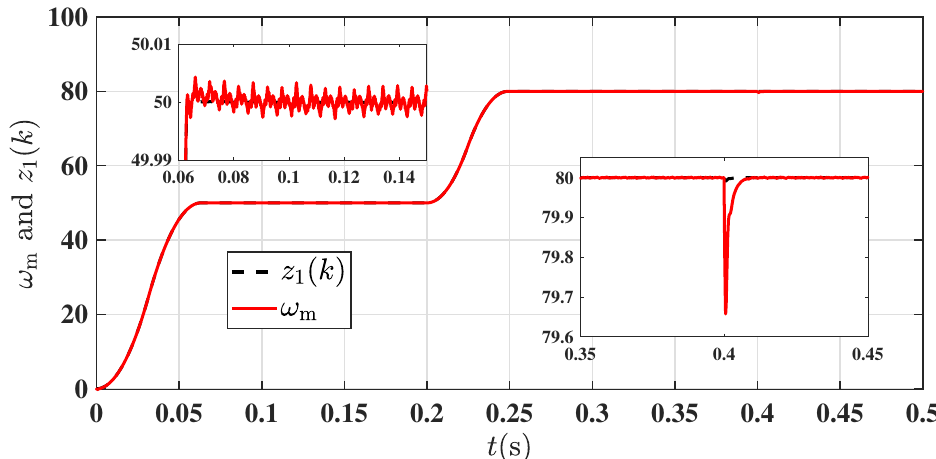
Figure 6. The velocity response ω m and its ESO-based estimation value.